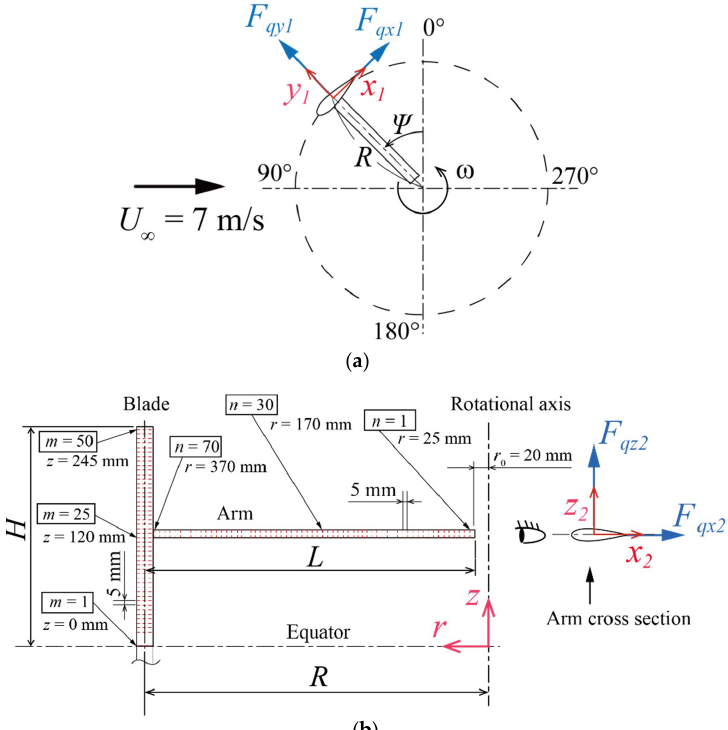
Figure 9. Schematic drawings showing the definition of azimuth, the positions where surface pressure and friction are estimated, and the relative coordinates, by which the forces are defined: ( a ) relative coordinates regarding a blade and ( b ) relative coordinates regarding an arm.